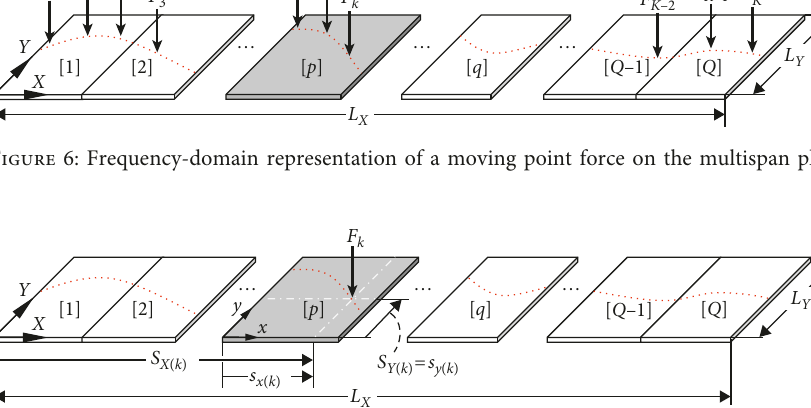
Figure 7: A multispan rectangular plate subjected to a stationary point force F